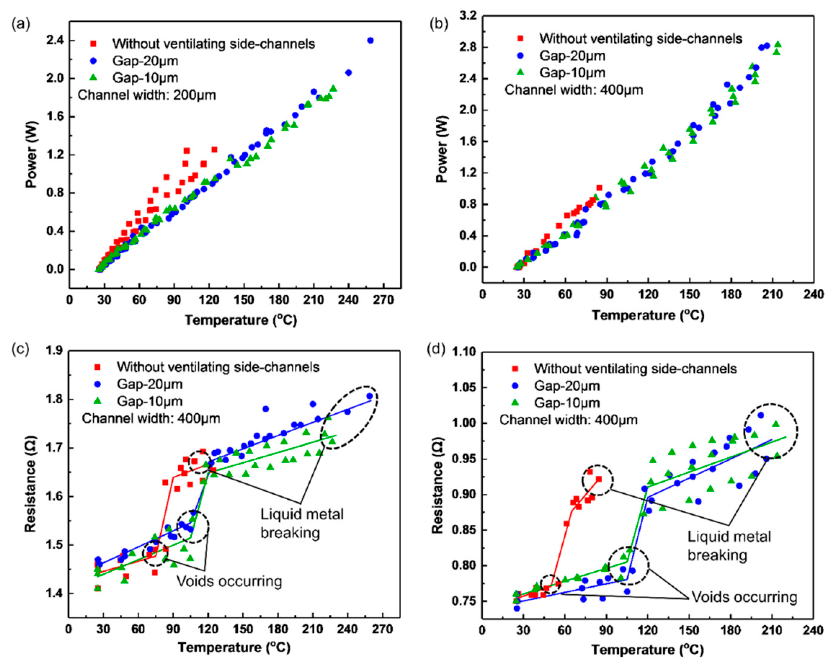
Figure 3. Power of the microheaters with ( a ) 200 µ m- and ( b ) 400 µ m-wide liquid-metal heating channel as functions of temperature; Resistance of the microheaters with ( c ) 200 µ m- and ( d ) 400 µ m-wide liquid- metal heating channel as funtions of temperature. Three repeated measurements are shown.